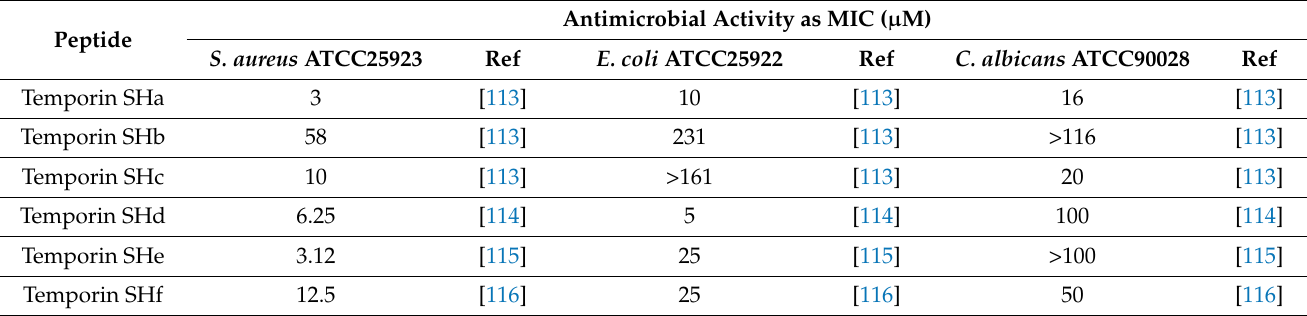
Table 10. Antimicrobial activity against selected microorganisms of temporins